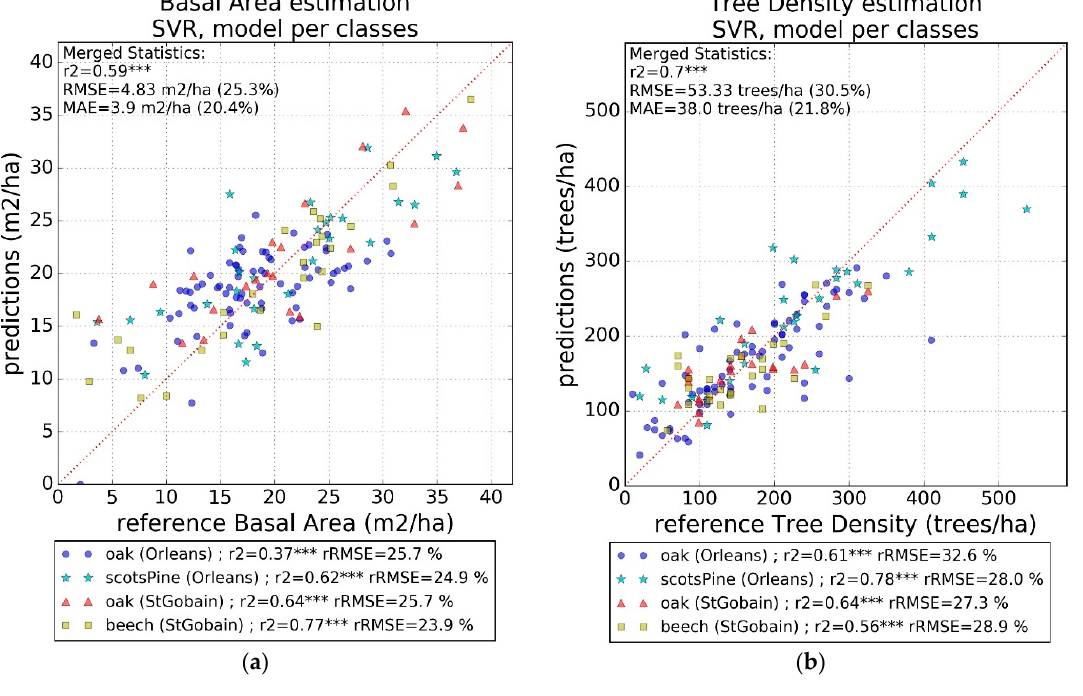
Figure A1. Validation scatterplot forest parameters estimation with ONF field measurements and satellite remote sensing data. ( a ) dominant height (Hdom); ( b ) mean diameter at breast height (DBH). Statistical signicicance: *** p ≤ 0.001.